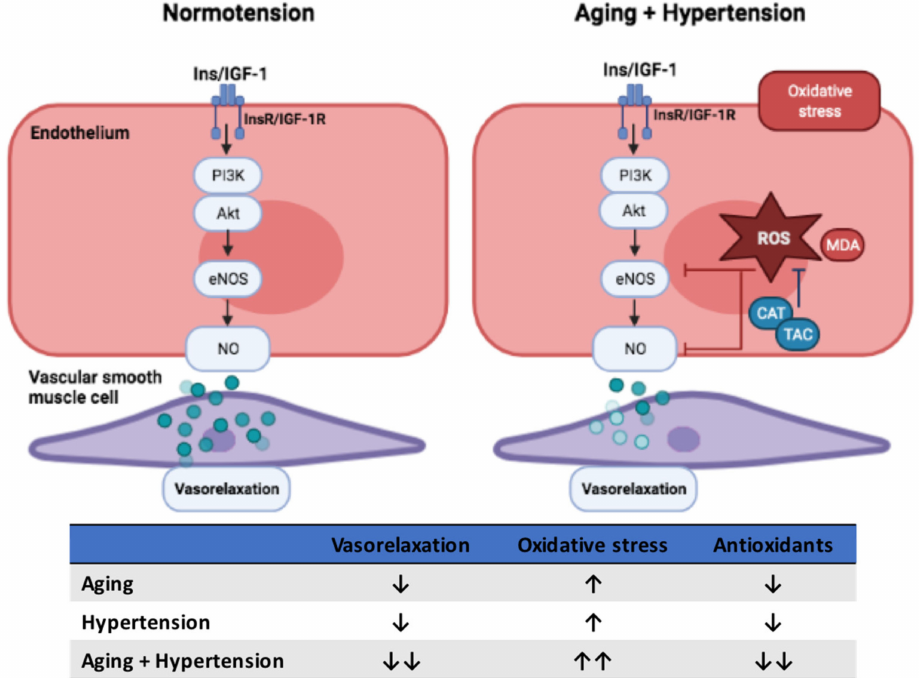
Figure 6. The proposed scheme demonstrating potential mechanisms involved in the impaired insulin- and IGF-1-mediated vascular relaxation in age-related hypertension. The excessive production of ROS and antioxidant deficiency in either aging or hypertension reduced NO production and consequently impaired insulin- and IGF-1-mediated vascular relaxation. Furthermore, our finding indicated that the process of aging additively affected insulin- and IGF-1-mediated endothelial dysfunction in aging-related hypertension, which was partly attributed to the reduced NO production and imbalance of oxidative and antioxidant activities in hypertension. Ins, insulin; IGF-1, insulin-like growth factor-1; R, receptors; PI3K, phosphoinositide 3-kinase; Akt, protein kinase B; eNOS, endothelial nitric oxide synthase; MDA, malondialdehyde; CAT, catalase activity; TAC, total antioxidant capacity; ↑ , increasing; ↑↑ , more increasing; ↓ , decreasing; ↓↓ , more